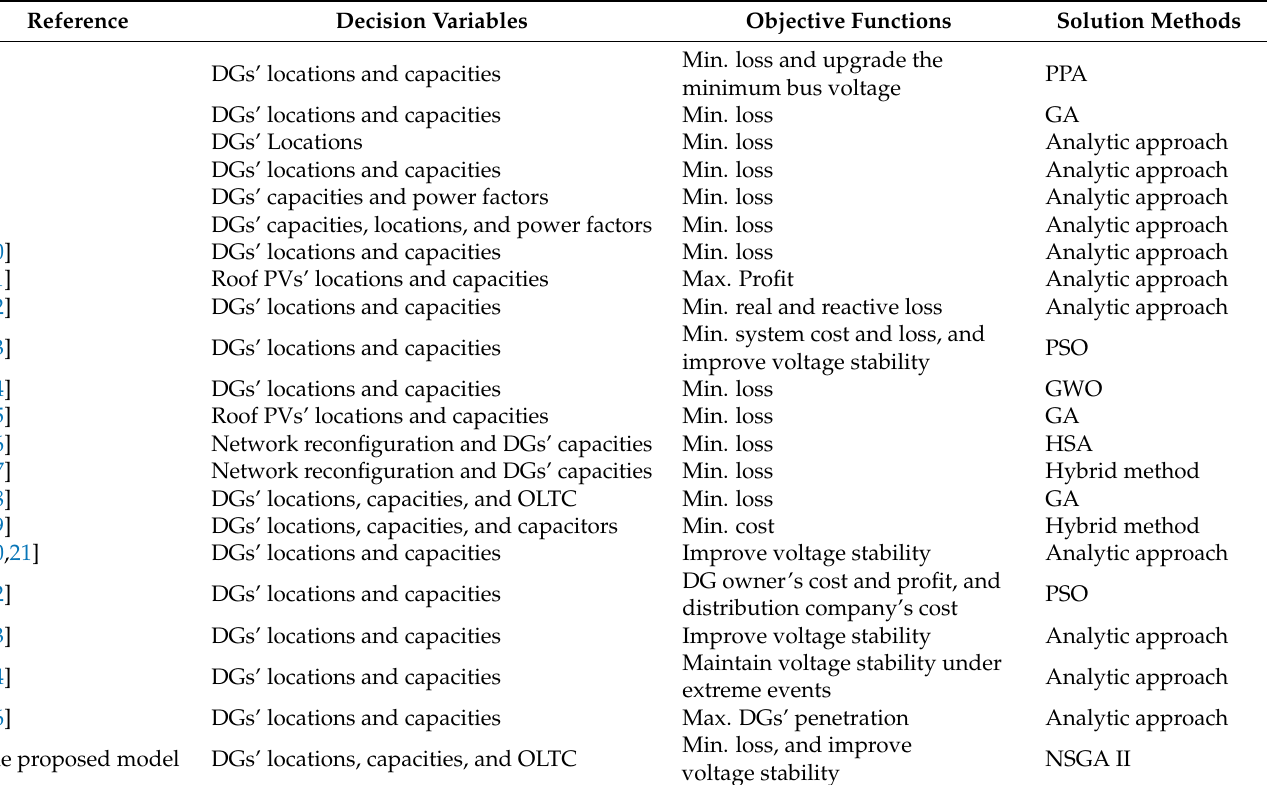
Table 1. Summary of the literature reviews and the proposed